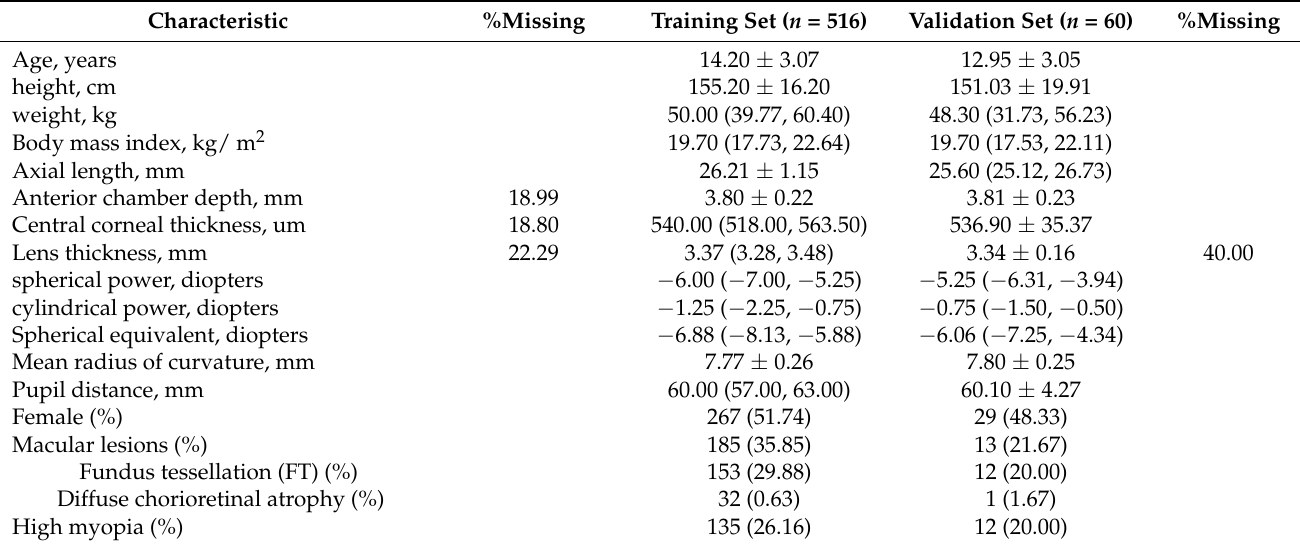
Table 1. Systemic and ophthalmological parameters of included